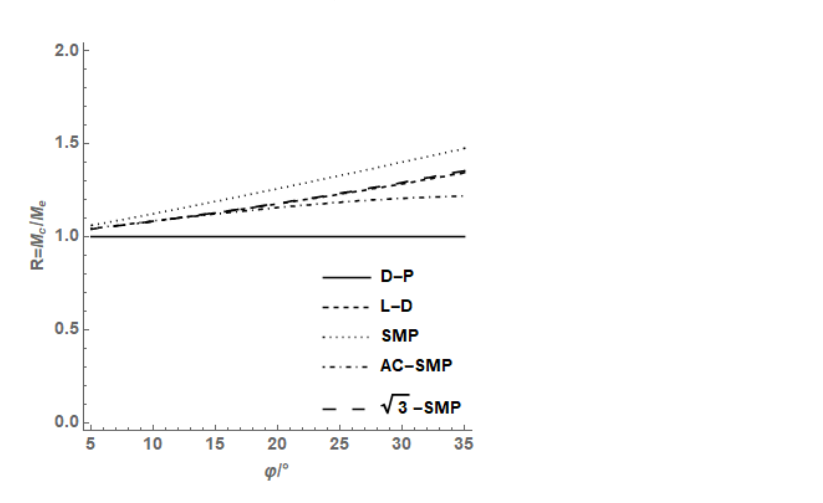
Figure 5. The relationship between